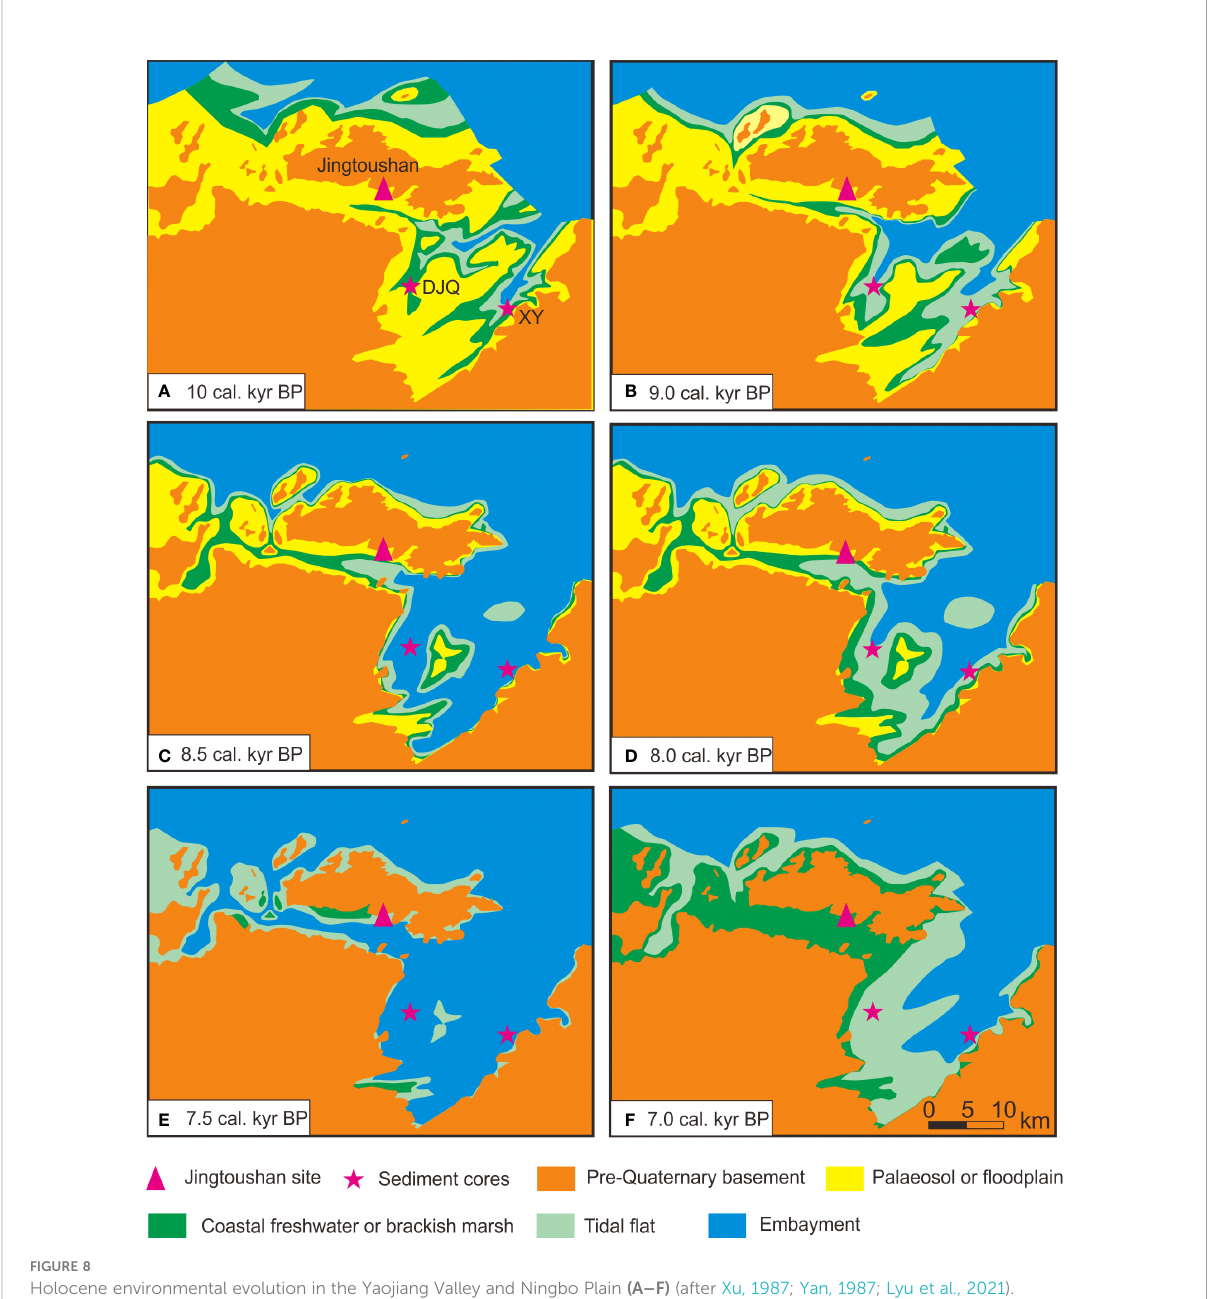
FIGURE 8 Holocene environmental evolution in the Yaojiang Valley and Ningbo Plain (A – F) (after Xu, 1987; Yan, 1987; Lyu et al.,